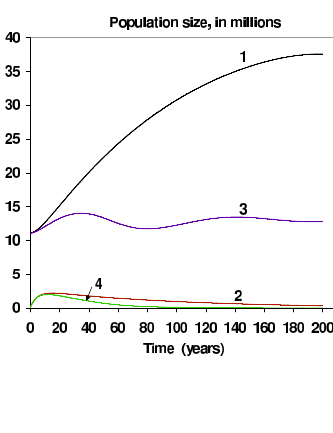
Figure 3. Simulated quarantine on the susceptible ( S ) and recovered ( R T ). Trends 1, 2, 3 and 4 represent the susceptible population with quarantine for MDRTB, recovered population with quarantine for MDRTB, susceptible population without quarantine for MDRTB, and recovered population without quarantine for MDRTB. Parameter values are those of Table